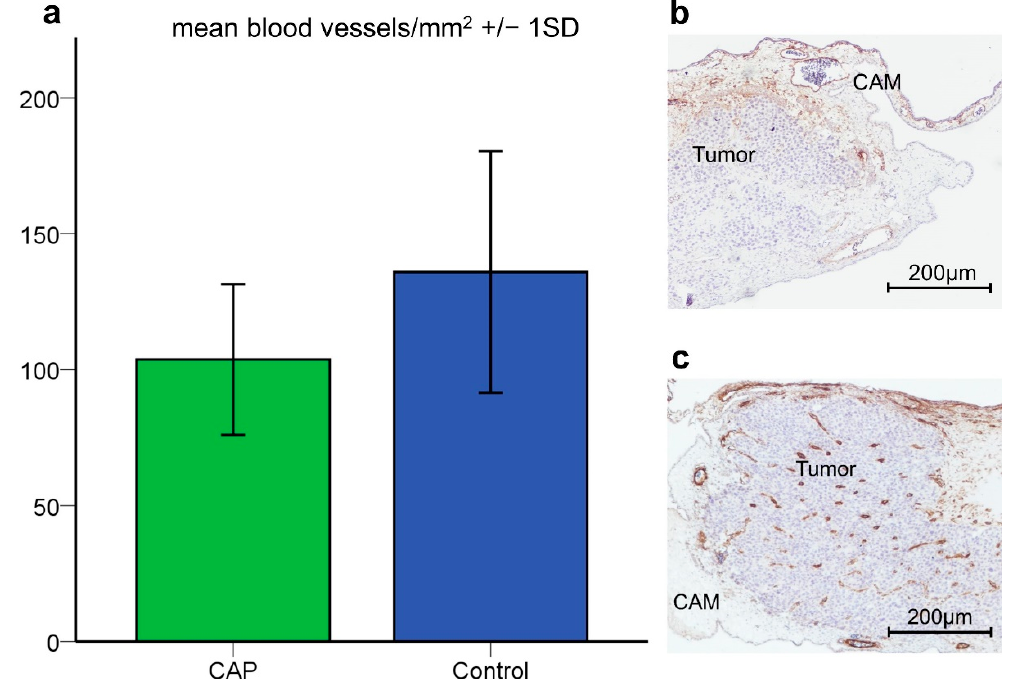
Figure 2. Vessel density in the tumor tissue. ( a ) The mean number of blood vessels per mm 2 was significantly lower in tumors treated with 4 × 60 s CAP compared to sham-treated specimens. ( b ) Representative image of α -SMA-stained slide of low vascularized tumor tissue (CAP), scale bar length 200 µm. ( c ) Representative image of α -SMA stained slide of well-vascularized tumor tissue, scale bar length 200 µm (Control). * p < 0.05.